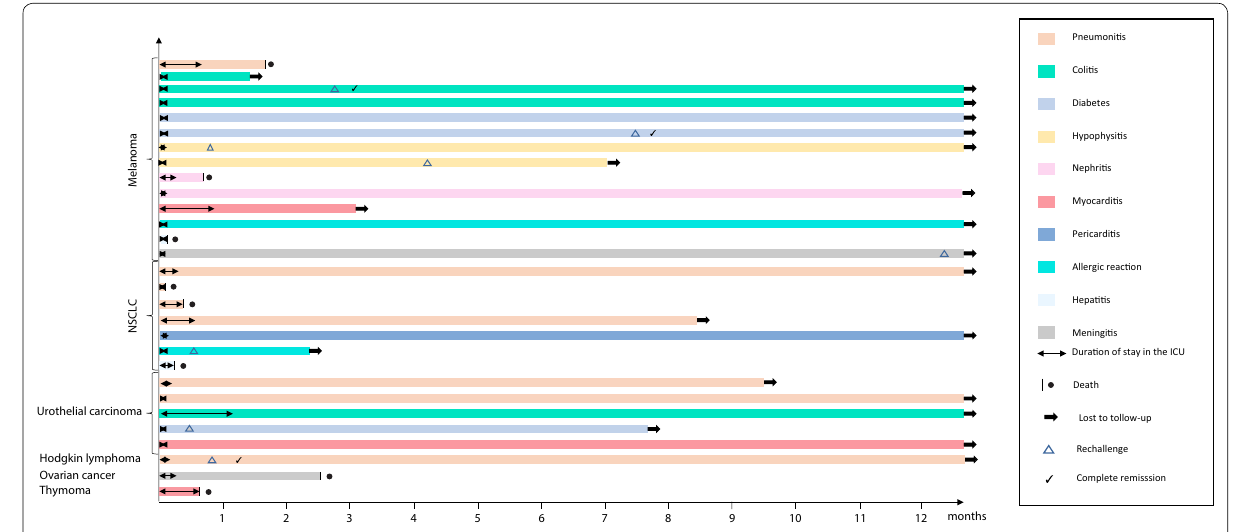
Fig. 2 Swimmer plot of patients admitted for immune‑related adverse events and evolution after discharge from ICU. An arrow represents the moment when the patient is lost to follow‑up, a dot represents the moment of death. NSCLC non‑small cell lung cancer, ICU intensive care